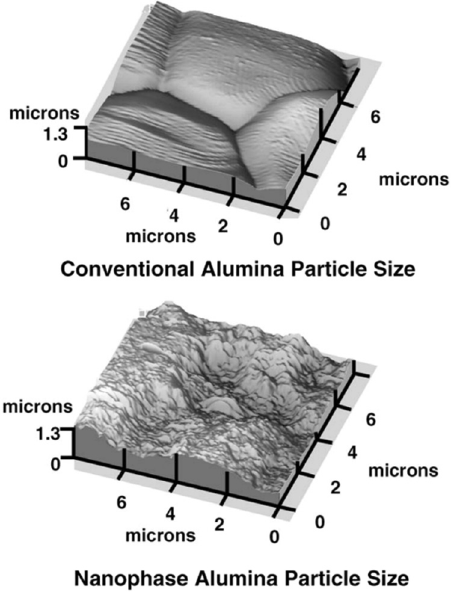
Figure 13: Enhanced adhesion of osteoblasts was observed on nanometer particles of alumina compared to conventional metals ( reproduced from ref. [ 101 ])